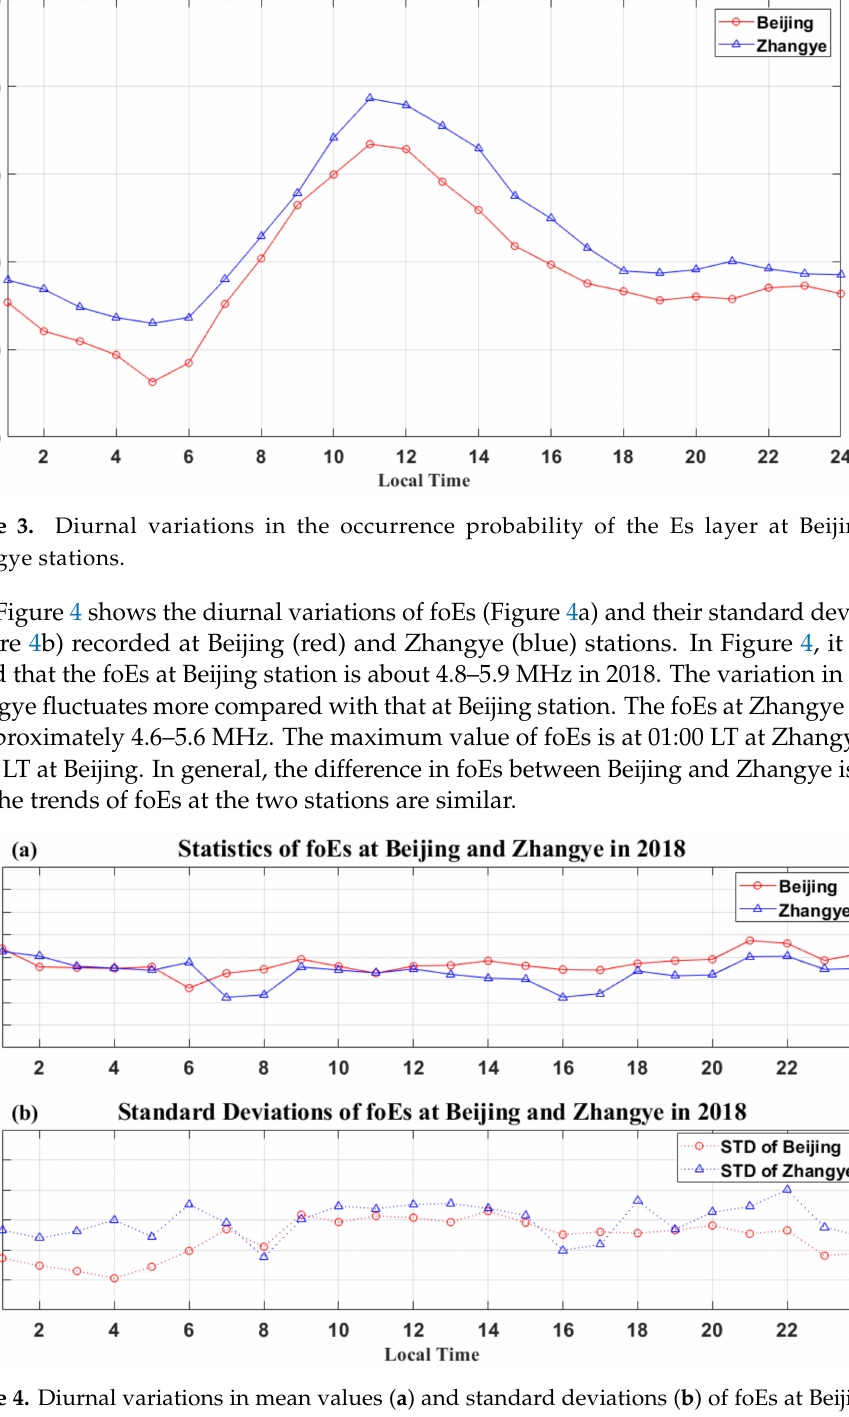
Figure 4. Diurnal variations in mean values ( a ) and standard deviations ( b ) of foEs at Beijing and Zhangye